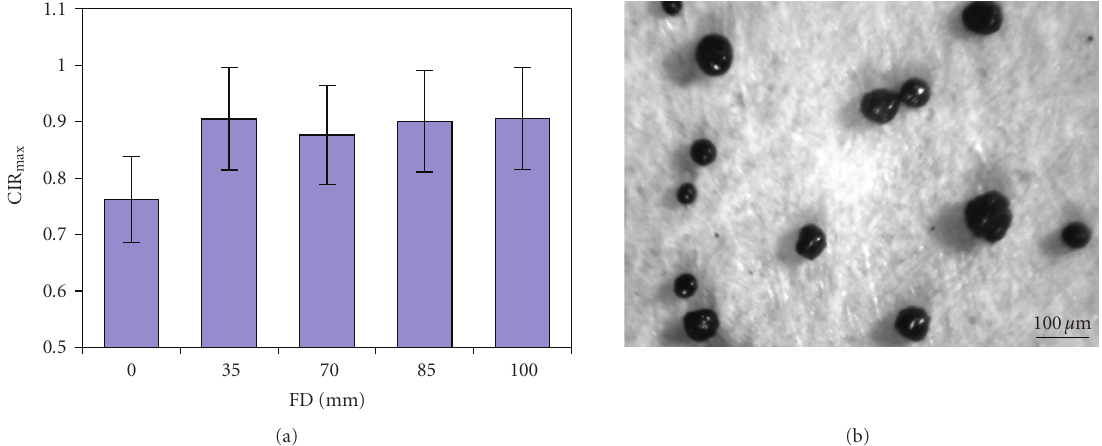
Figure 3: (a) Circularity of free-flight particles of WC-17Co. (b) Microimage of free-flight particles; light microscopy in reflected light.